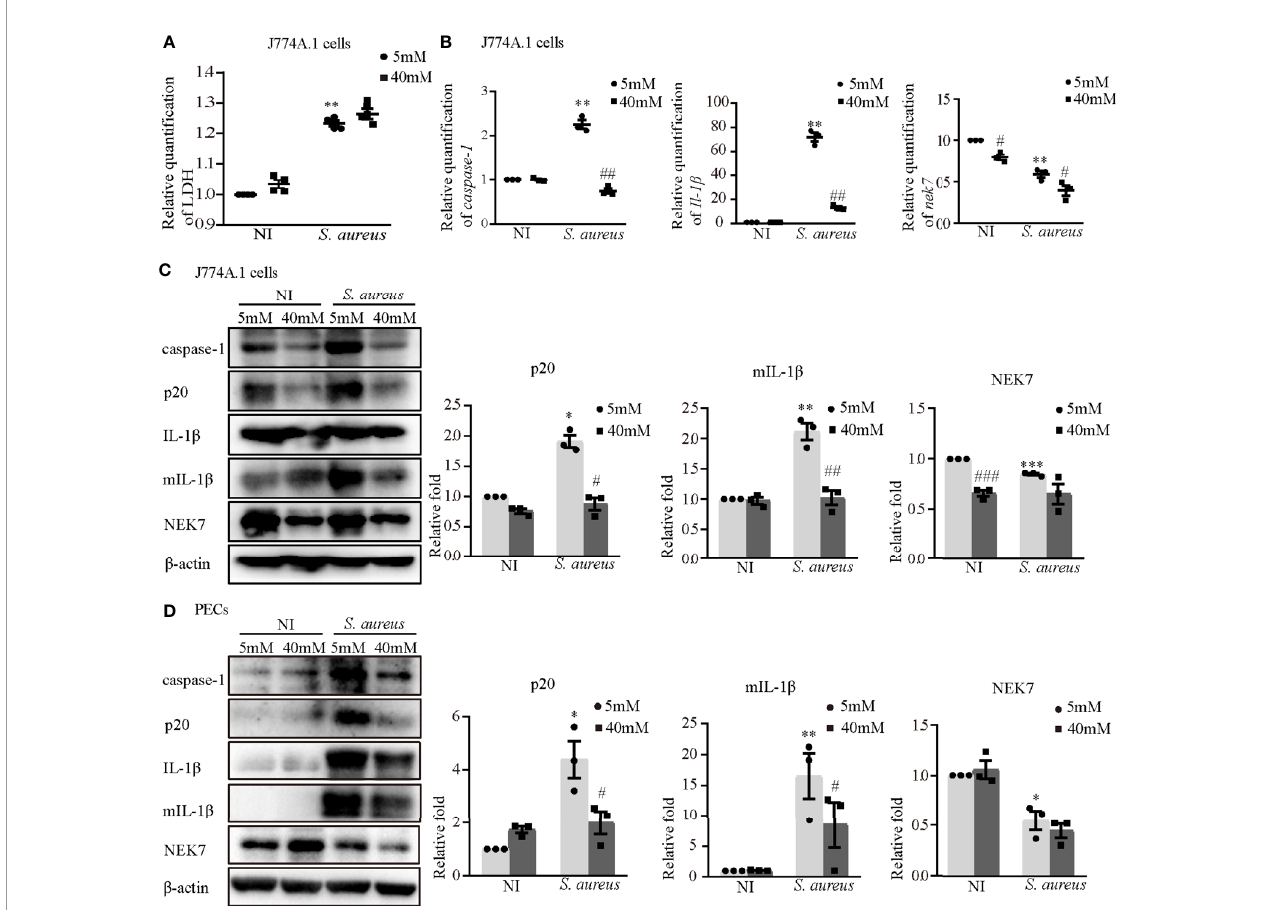
FIGURE 9 | Blockade of potassium ef fl ux downregulated NLRP3 in fl ammasome activation and NEK7 expression. J774A.1 cells (A – C) and PECs (D) were infected with S. aureus infection (MOI of 1) for 24 h in the presence of different concentration of KCl (5 mM or 40 mM). (A) The level of LDH in the supernatants were detected. (B) The mRNA expression levels of caspase-1 , Il-1 b and nek7 were examined by RT-PCR. (C) The protein expression levels of caspase-1, p20, pro-IL-1 b , mIL-1 b and NEK7 were detected by western blot and analyzed by relative densitometric quanti fi cation in J774A.1 cells and PECs (D) . Similar results were obtained in three independent experiments in data. Data shown are means ± SEMs; * P < 0.05, ** P < 0.01, *** P < 0.001 vs. non-infection control group, # P <0.05, ## P < 0.01, ### P < 0.001 vs . infection control